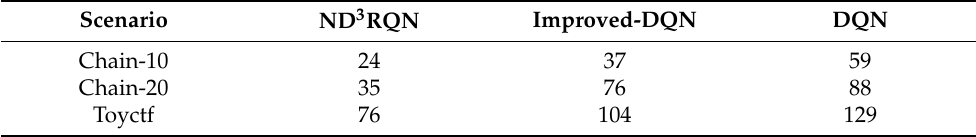
Table 6. Solved episodes is the minimum episodes for the agent to learn the optimal